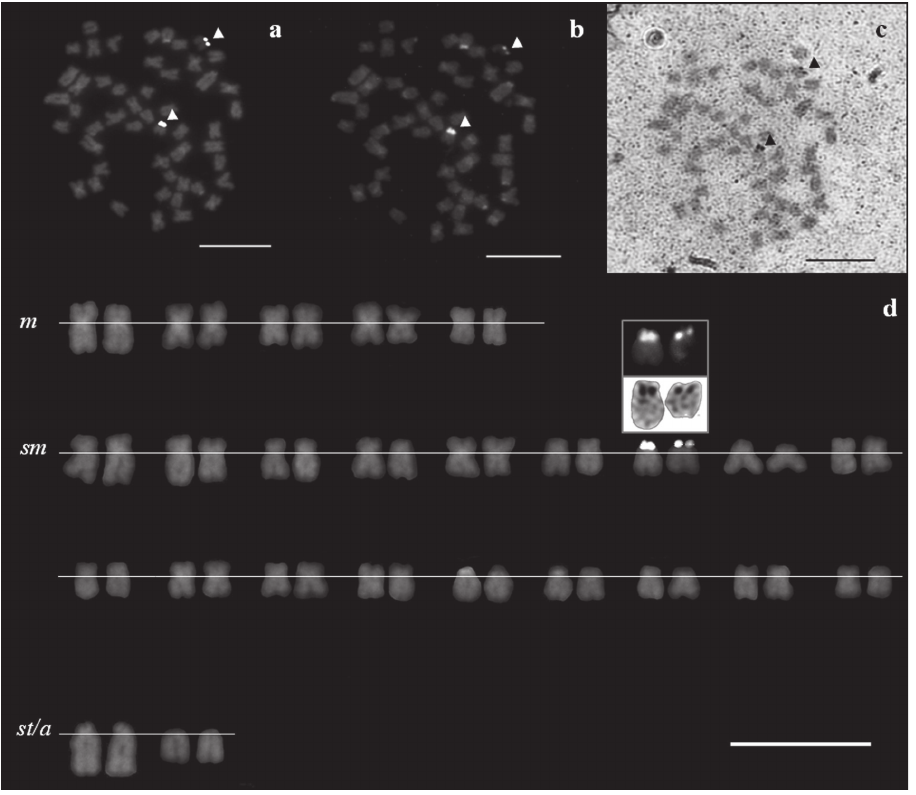
Figure 3. Metaphase spreads of a S. torgalensis , stained with sequential treatments a rDNA FISH b CMA -NOR, and c Ag-NOR treatments d corresponding karyotype of the same individual after rDNA 3 FISH, with CMA - and Ag-NOR signals inset. NORs are indicated by arrowheads. Scale bar = 3